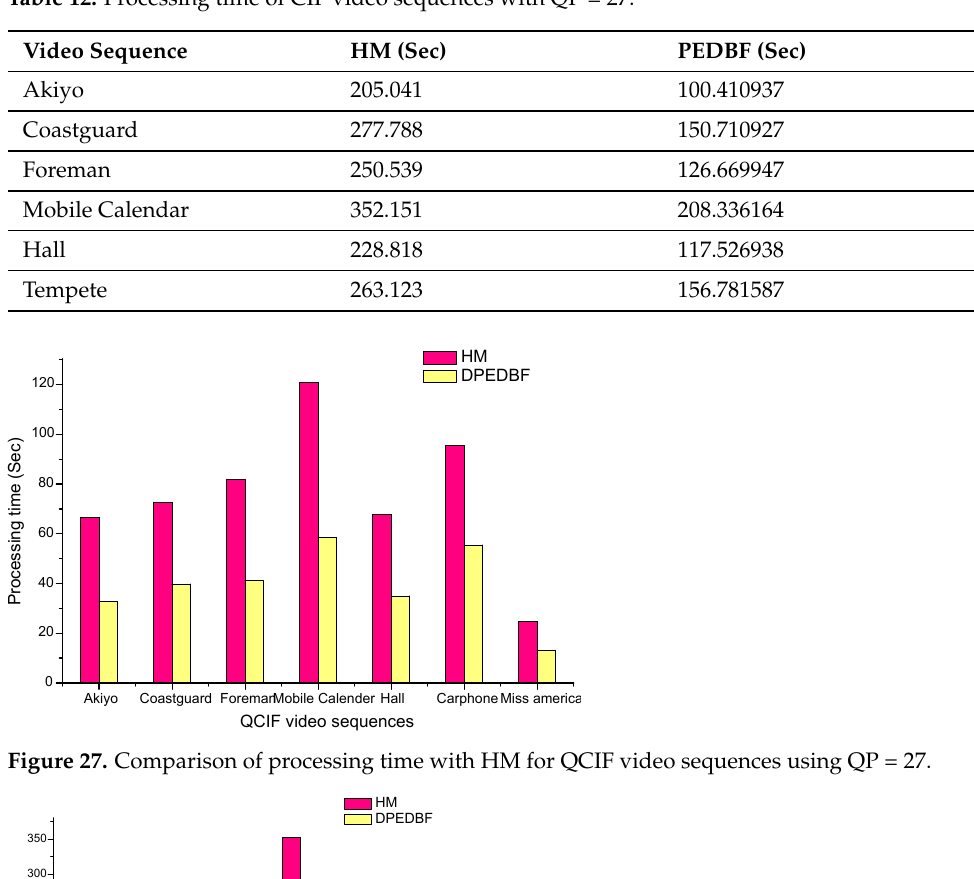
Table 12. Processing time of CIF video sequences with QP = 27.